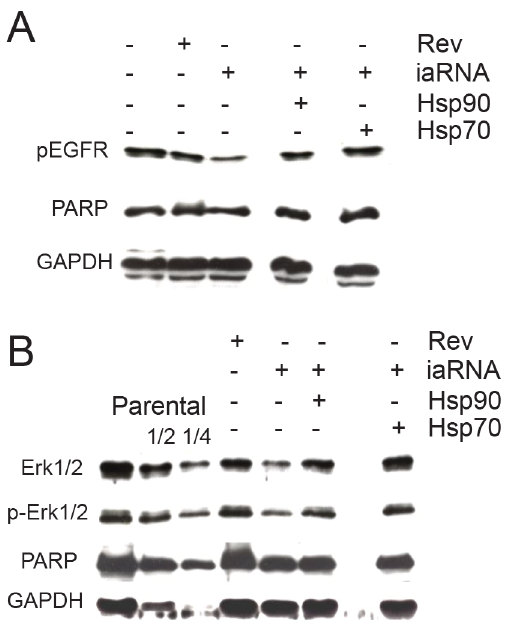
Figure 6. HSF1 aptamer inhibits mitogenic signaling. ( A ) HSF1 inhibition attenuates EGF receptor activation following the addition of EGF to HeLa cells. ( B ) HSF1 inhibition by iaRNA HSF1 causes a depletion of the total levels and activated forms of Erk1/2. The left most three lanes are a serial dilution of parental line extracts that provides a quantification standard curve. Ectopic expression of HSP70 or HSP90 suppresses the inhibition of mitogenic signaling in the iaRNA HSF1 expressing